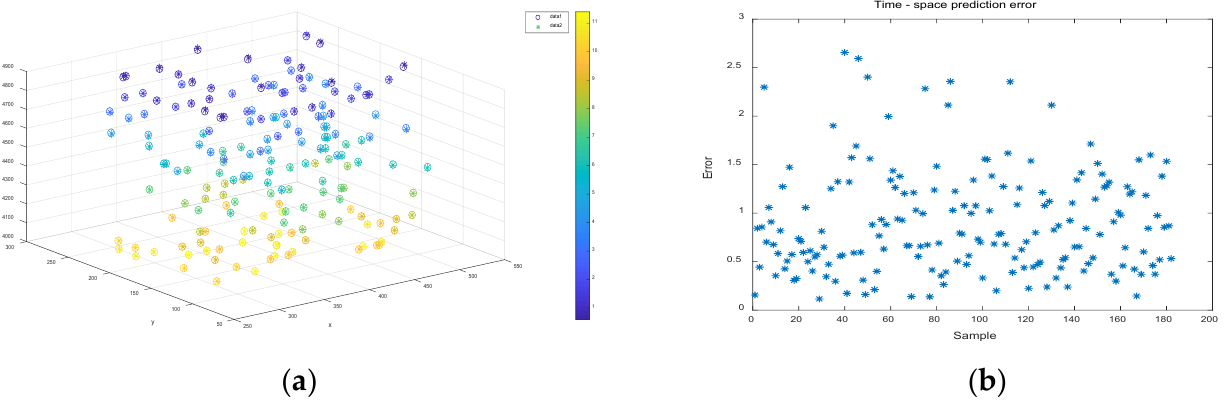
Figure 9. Time-space localization prediction and error of sample points for speed 20 mm/s sample bank test. ( a ) Four-dimensional positioning prediction results; ( b ) spatio-temporal positioning prediction error.